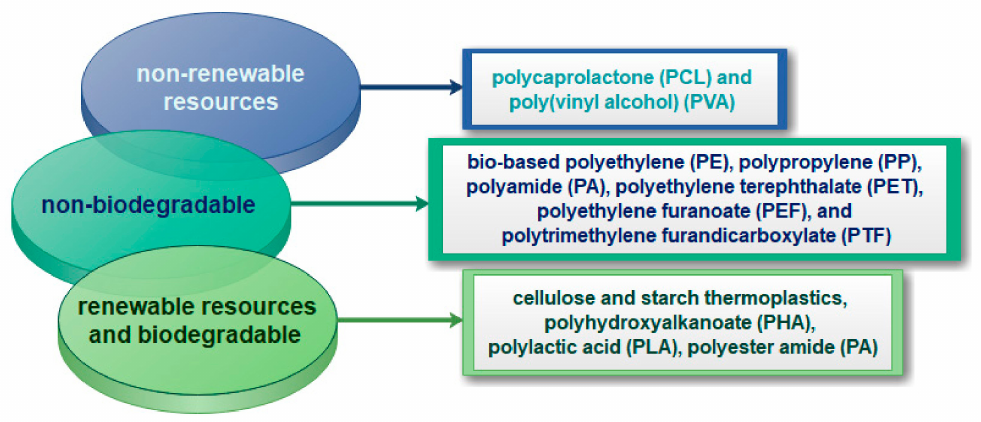
Figure 8. Bio-based materials for food packaging applications